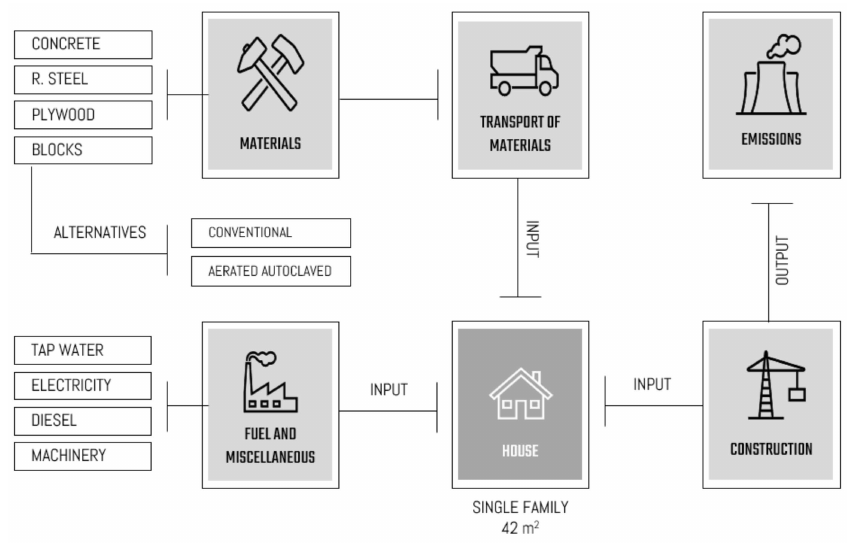
Figure 6. System limits, where the processes considered for the construction of both houses are shown. Made by the authors.